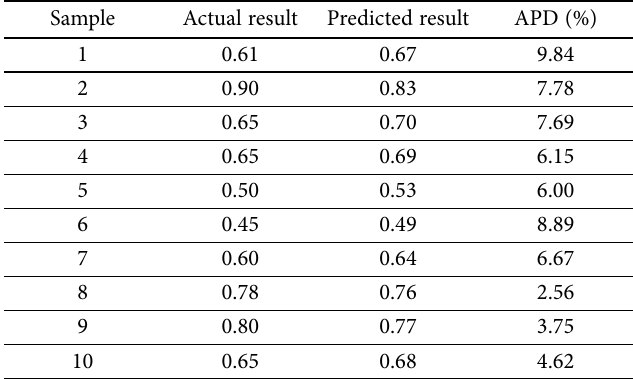
Table 6. Comparison of actual and assessed results of collusion